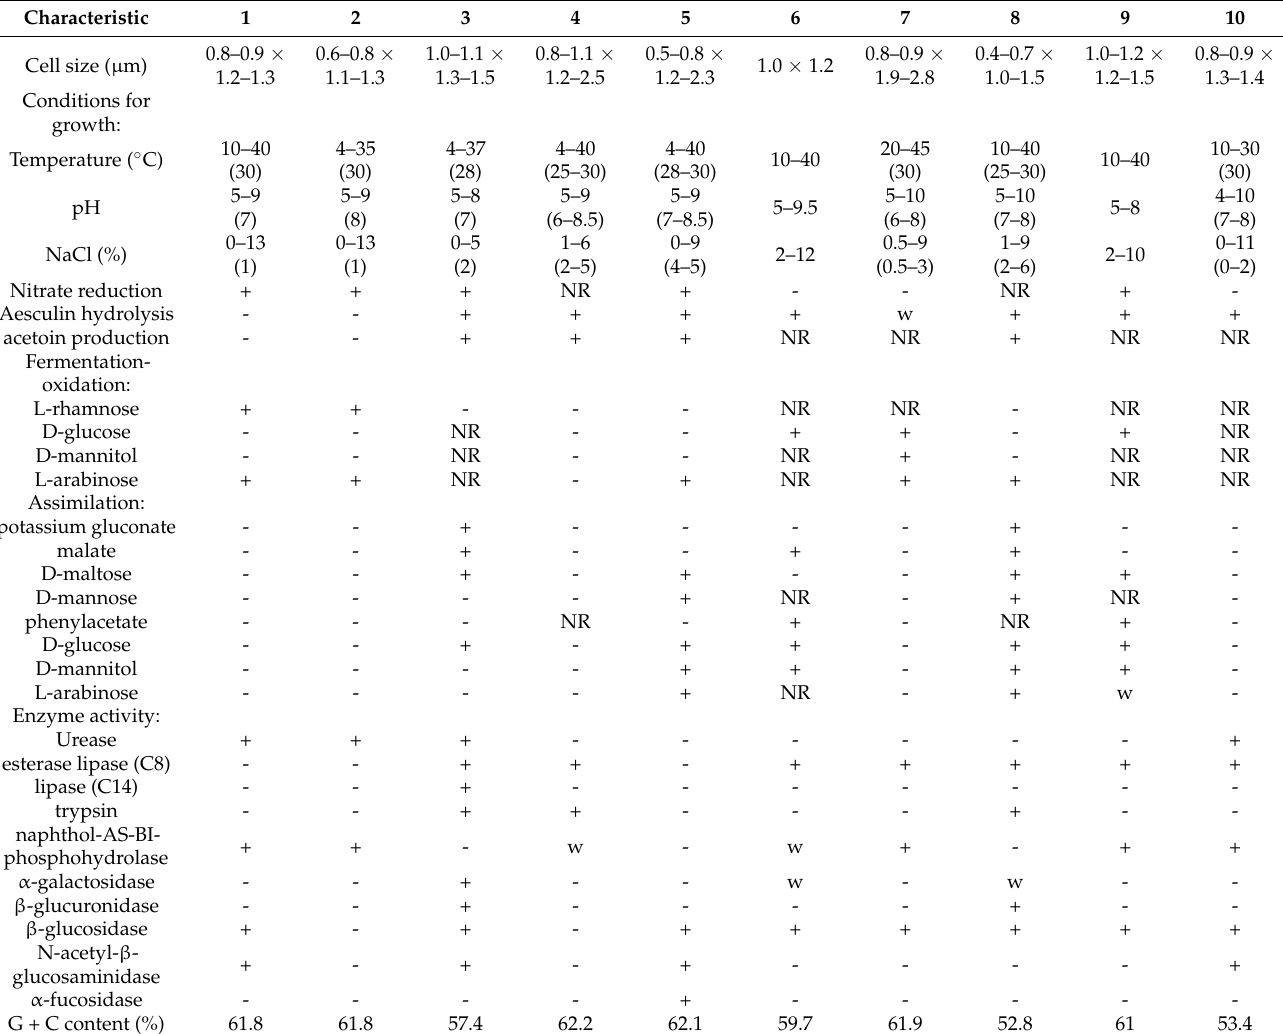
Table 1. Differential characteristics of strains NC18 T and NC20 with related taxa within the genus Martelella .